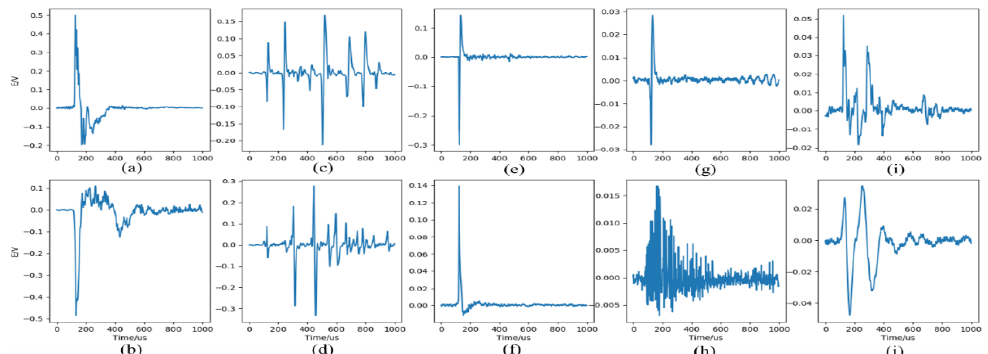
Figure 3. Example of some typical very low frequency / low frequency (VLF / LF) electric field waveforms. ( a ) negative cloud-to-ground flash ( − CG), ( b ) positive CG ( + CG), ( c ) negative pre-breakdown ( − PBP), ( d ) positive PBP ( + PBP), ( e ) negative narrow bipolar event ( − NBE), ( f ) positive NBE ( + NBE), ( g ) NBE, ( h ) multi-pulse cloud flash (MP), ( i ) cloud ground flash with ionosphere reflected signals (CG-IR), ( j ) skywave (SW).